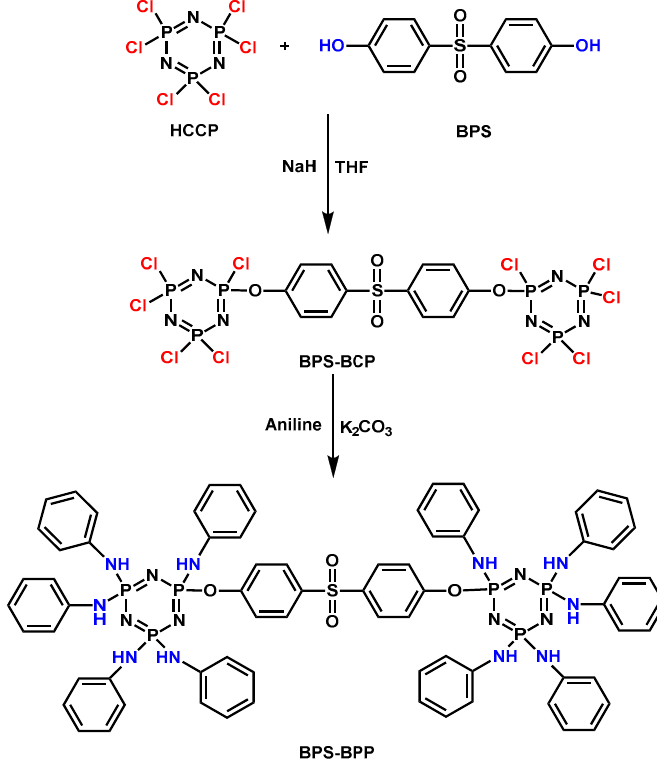
Figure 12. Synthetic route of BPS-BPP. Readapted with permission from Ref. [103], Copyright 2016 Elsevier Ltd.